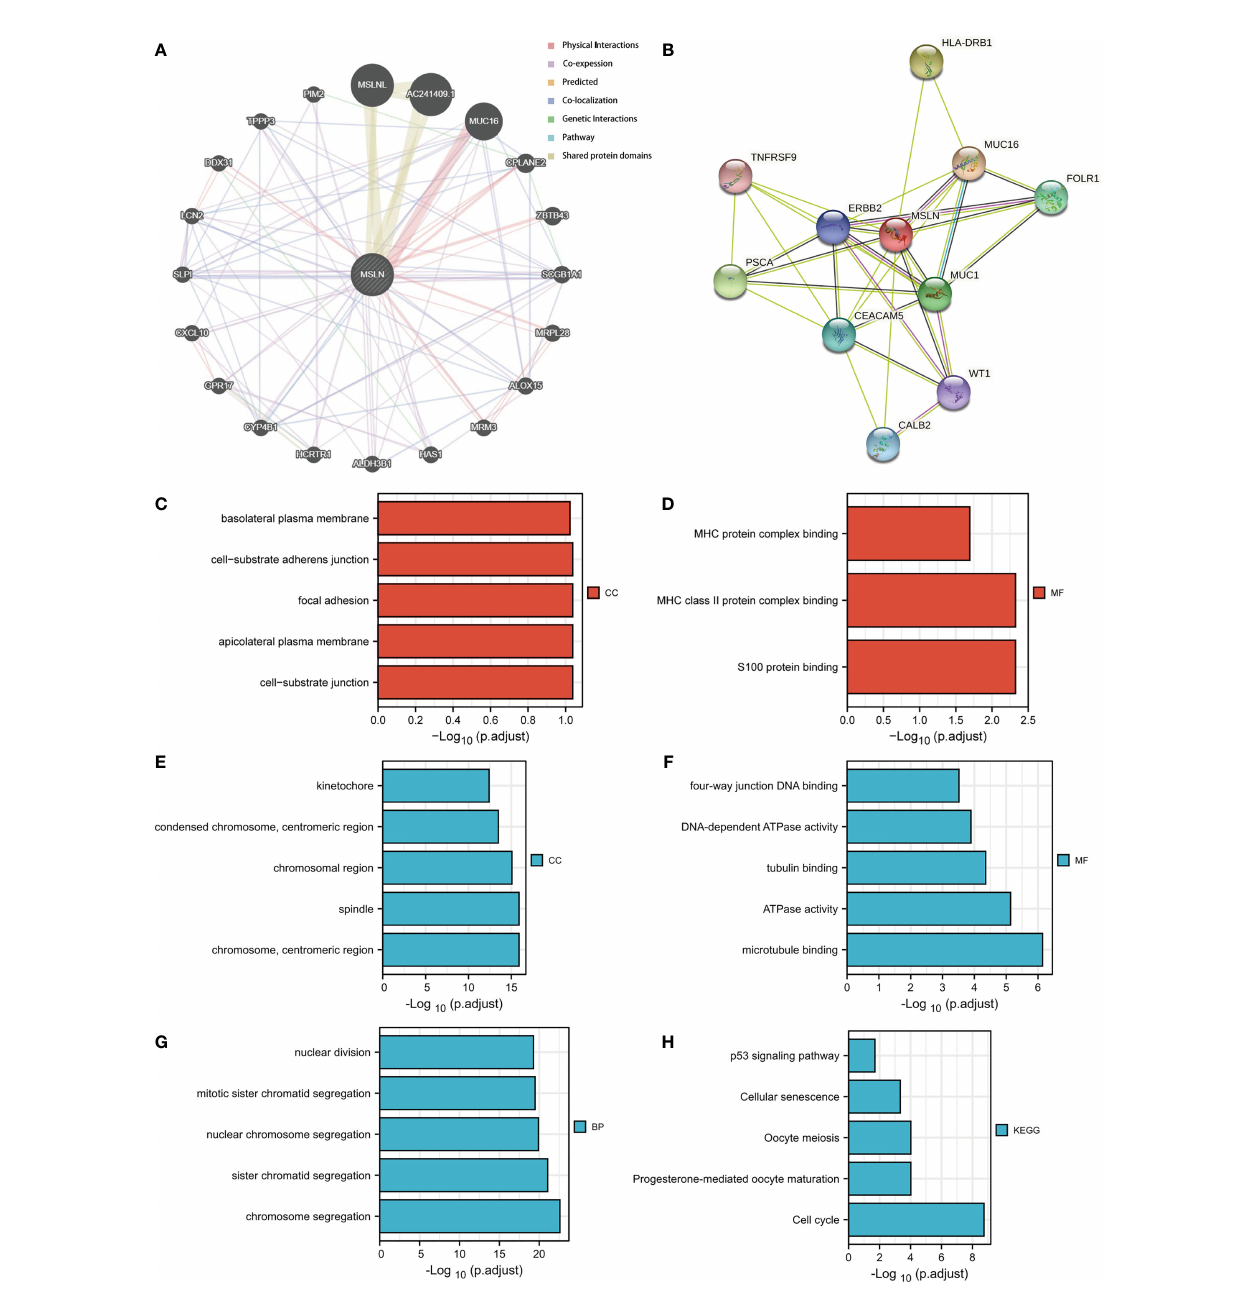
FIGURE 6 | Function and pathway enrichment analyses of MSLN in ovarian cancer. (A) The gene-gene interaction network of MSLN was constructed using GeneMania. (B) A MSLN PPI network constructed using the STRING database. (C, D) Signi fi cant Gene Ontology terms of the top 300 genes most positively associated with MSLN, including cell component (CC), and molecular function (MF). (E – G) Signi fi cant Gene Ontology terms of the top 300 genes most negatively associated with MSLN, including cell component (CC), molecular function (MF), and biological processes (BP). (H) Signi fi cant KEGG pathways of the top 300 genes most negatively associated with